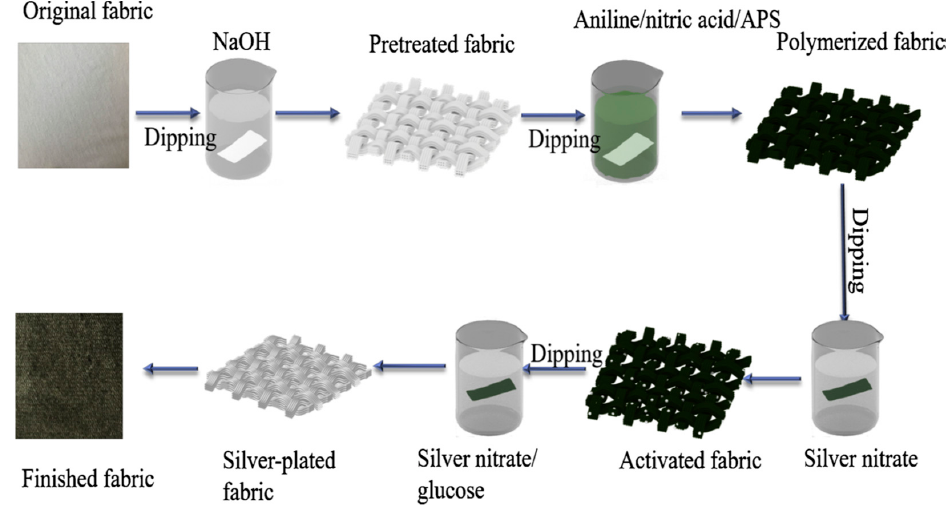
Figure 14. The preparation process of silver-plated fabric. Reprinted with permission from Ref. [33]. Copyright 2019, Elsevier.